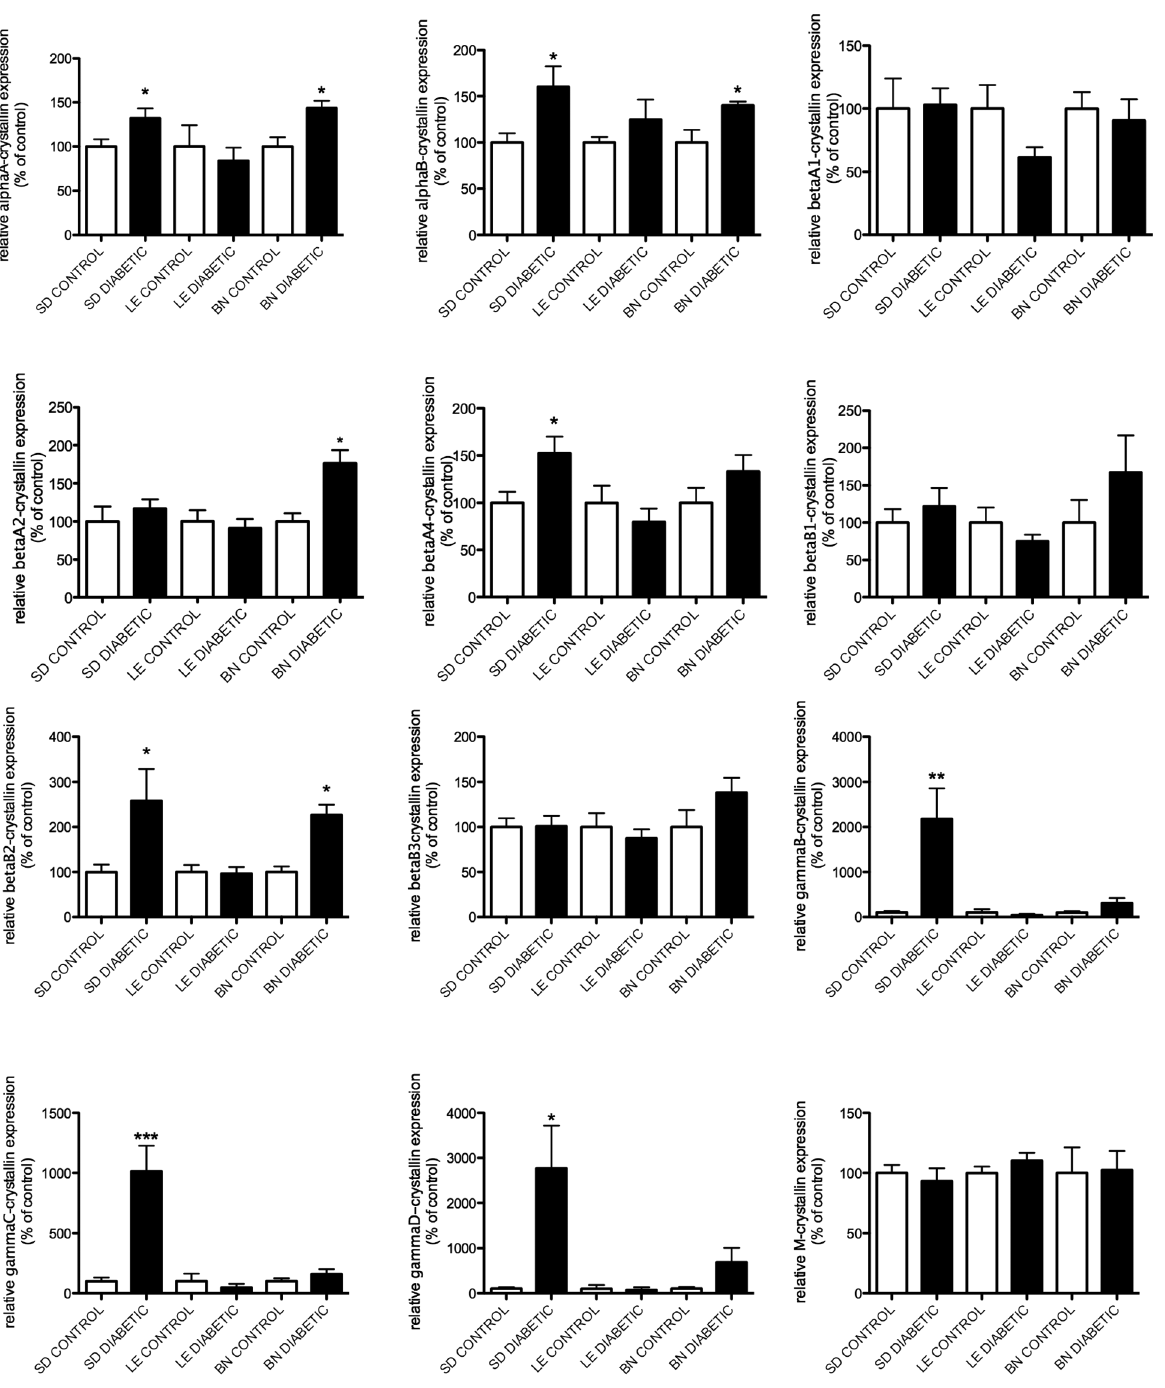
Figure 1. Gene expression analysis of crystallins after 4 weeks of diabetes. mRNA levels of crystallin genes (alpha-, beta- and gamma-) were assessed by Real Time PCR using gene-specific primers and probes 4 weeks after the onset of diabetes in Sprague Dawley (SD), Long Evans (LE) and Brown Norway (BN) rats. A representative graphic representation of the corresponding quantification is presented for alphaA-, alphaB-, betaA1-, betaA2-, betaA4-, betaB1-, betaB2-, betaB3-, gammaB-, gammaC-crystallin, gammaD- and M-crystallin mRNA respectively (A-L). *Significantly different from control [ P , 0.05].